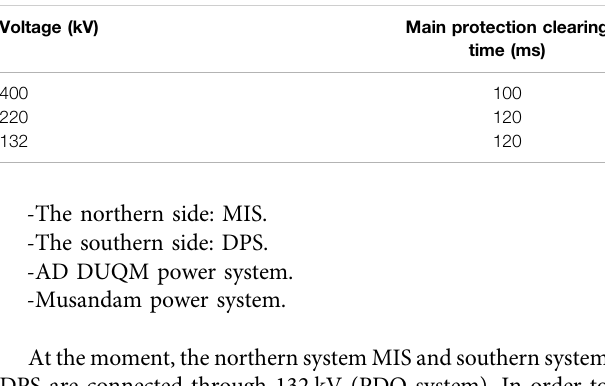
TABLE 6 | Fault clearing